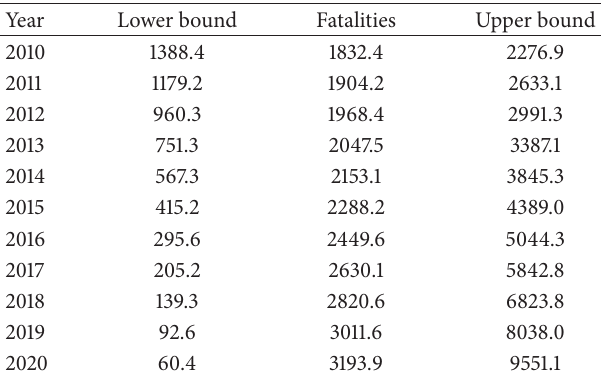
Table6:ForecastedabsolutenumbersofCambodianfatalitiesinthe